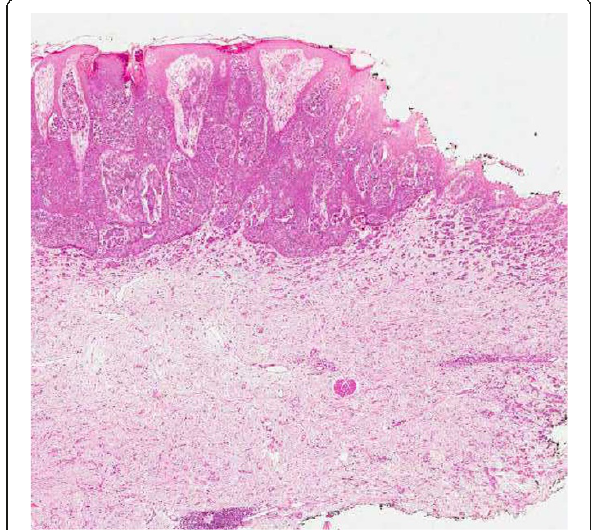
Figure 1 Skin and subcutis showing hyperplastic epidermis with “ clear cells ” suggestive of EMPD. The “ shoulder ” of the lesion reveals no epidermal involvement.